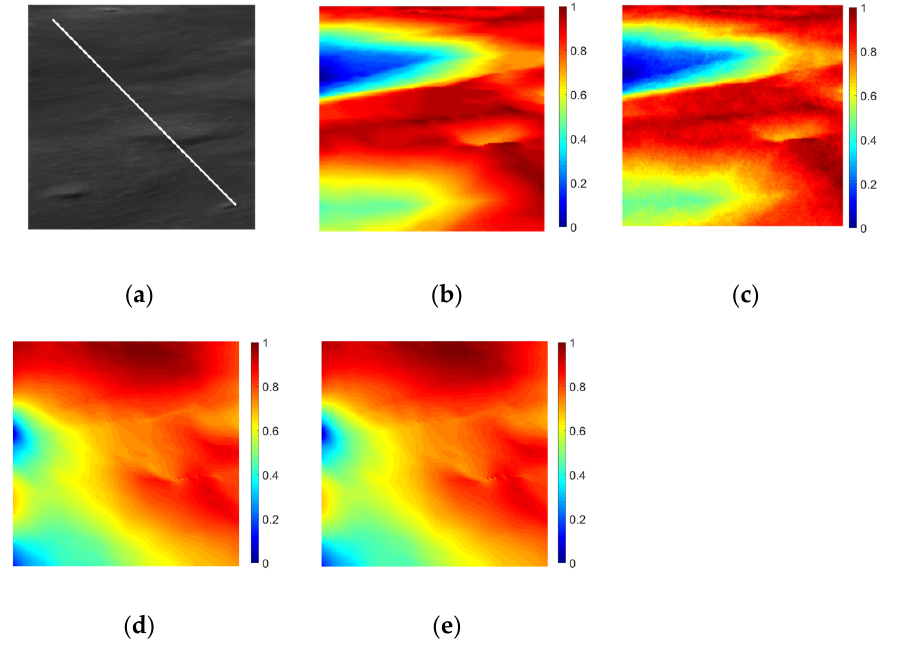
Figure 7. ROI 1 and reconstruction results of the three methods ( a ) Enlarged view of region 1, ( b ) ground truth, ( c ) PPS result, ( d ) PSPP result, ( e ) PSOP result.